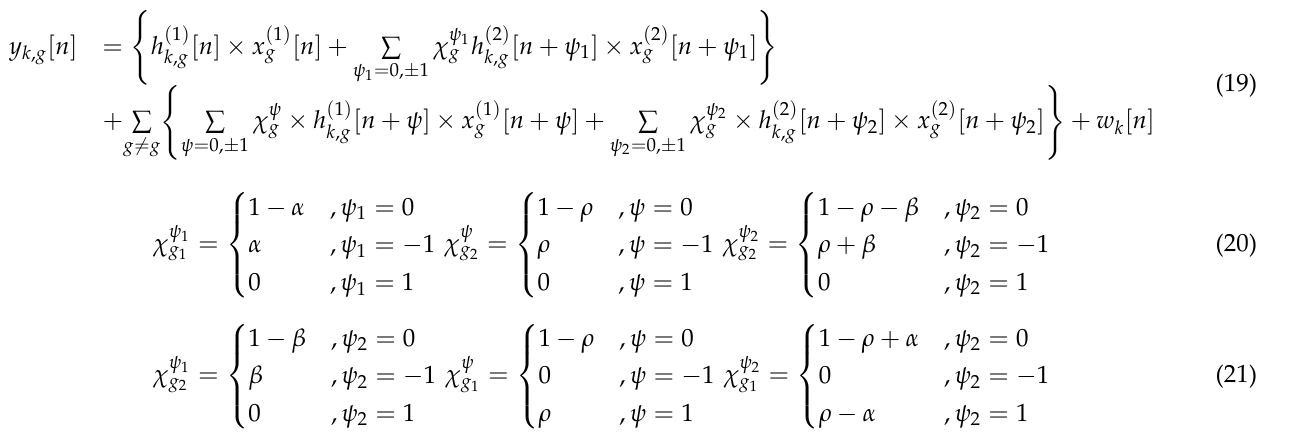
model, the symbols delayed will not be taken into consideration, causing a big performance loss. However, if all symbols are added into the iteration, the computing complexity will be raised to a higher level. Therefore, new algorithms should be proposed to balance the performance and the